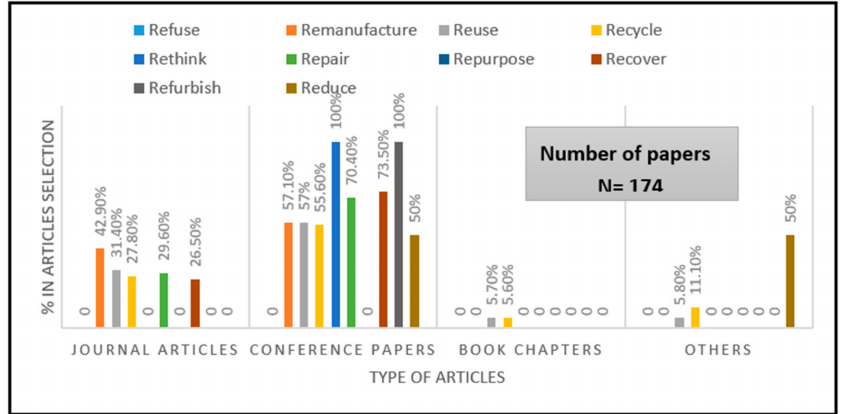
Figure 8. Papers distribution across Journals and Conference papers by